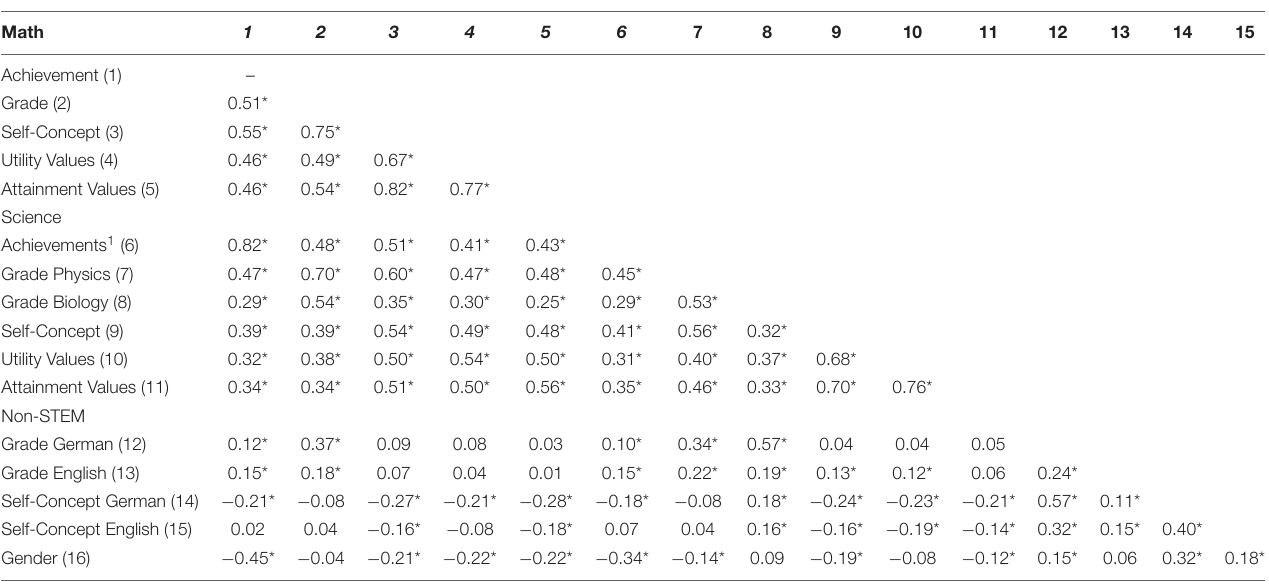
TABLE A2 | Correlations between the